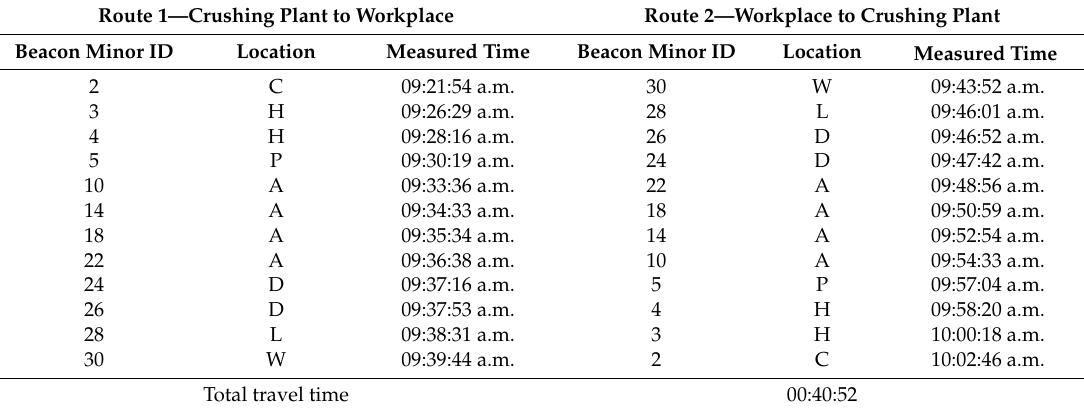
Table 4. Time data recorded when Bluetooth beacons were recognized on the BBUNS mobile app during one cycle of haulage operations. In the location part of the table, C denotes the crushing plant, H denotes the haul road outside the underground mine, P denotes the portal, A denotes the adit, D denotes the decline, L denotes the level, and W denotes the workplace. Route 1—Crushing Plant to Workplace Route 2—Workplace to Crushing